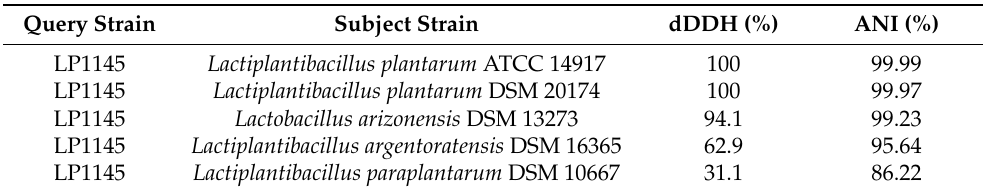
Table 4. Pairwise comparison of average nucleotide identity (ANI) and digital DNA-DNA (dDDH) hybridization values between Lpb. plantarum and the closely related type